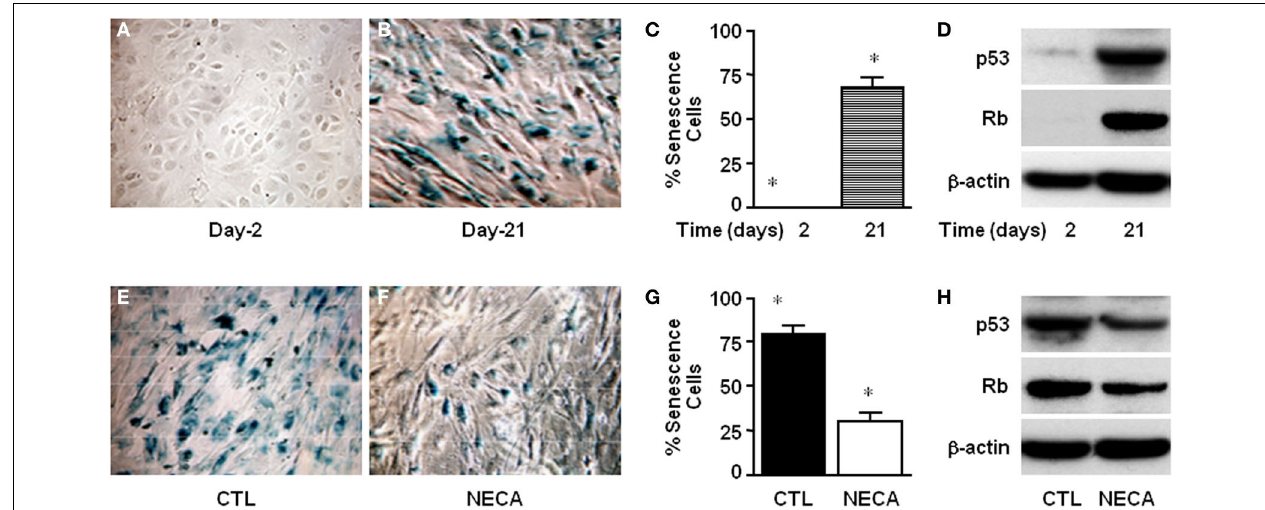
FIGURE 3 | NECA suppresses senescence by down regulating p53 and Rb in the primary rat HSC. Cells were cultured for 2–21 days and senescence detected using SA- β -Gal staining (A) at day-2 or (B) at day-21, and (C) the number of senescent cells quantified ( ∗ = significant but p value is not applicable because first column is totally zero). (D) Western blot analysis of p53 and Rb level in the normal culture at the day-2 or,